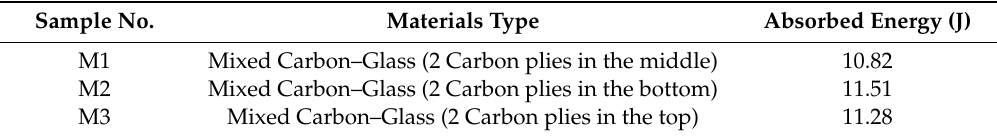
Table 5. Low-velocity impact test conditions and results for mixed-fiber plates. Sample